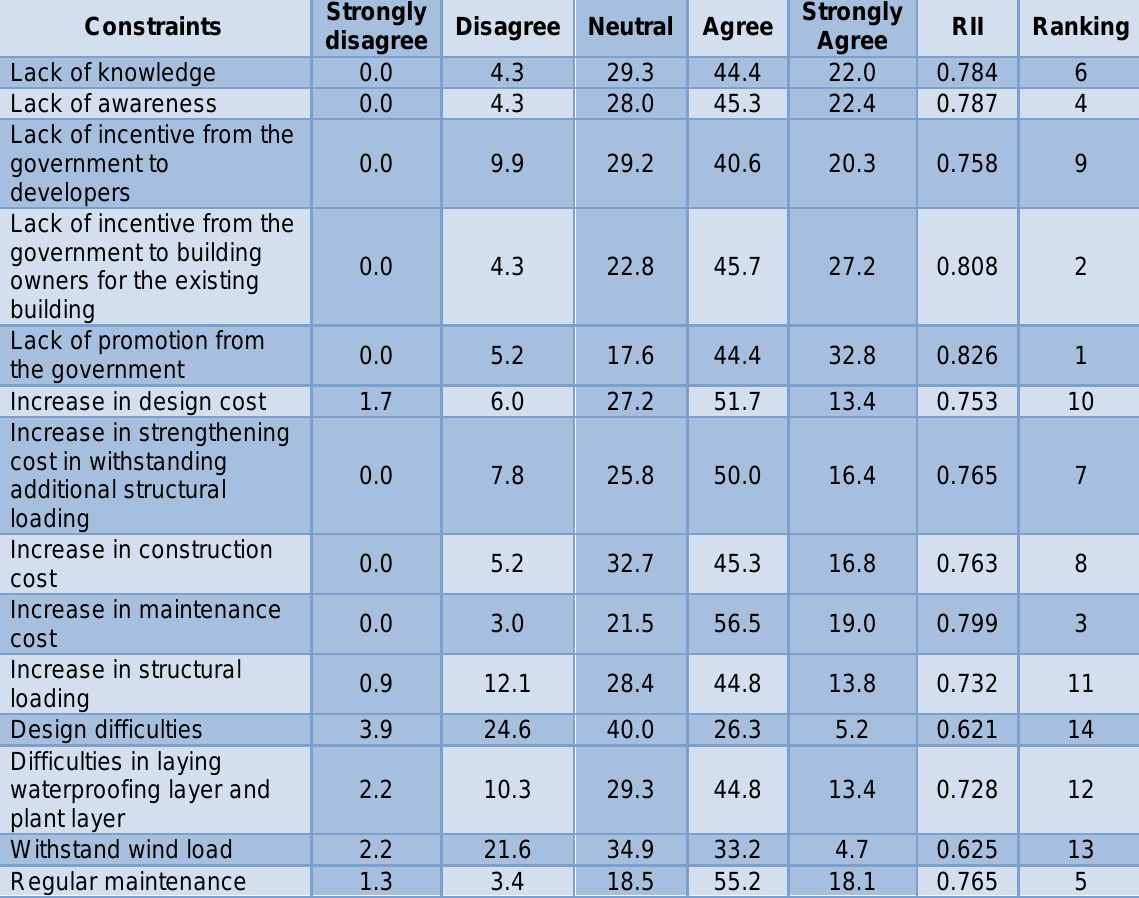
Table 8: Constraints in Implementing Extensive Green Roof Systems To encourage the implementation of extensive green roofs, nine measures are suggested based on the literatures (Koppany 2002; Grant et al. 2003; Liu and Baskaran 2003; Gedge and Frith 2004; Lagstrom 2004; Ngan 2004; Worden et al. 2004; Jenrick 2005; Rowe et al. 2005; Cutlip 2006; Getter and Rowe 2006; Legislative Council 2006; Urbis Limited 2007): (i) The government provides incentive to developers; (ii) The government provides incentive to owners of existing buildings; (iii) The government offers extra floor area bonus to the developers who construct certain green roof areas; (iv) Amount of green area compulsory in open space under property development regulations (v) Percentage of prescribed green space compulsory on roofs for property development projects; (vi) Green roof construction sets as a statutory requirement under certain conditions such as roof area, building size, use, etc; (vii) Setup guidelines for developers / contractors; (viii) Building with specified area of impervious surface is required to construct green roofs for reducing storm water pollution and flow rates; and (ix) Educate public to enhance the awareness of the importance of green